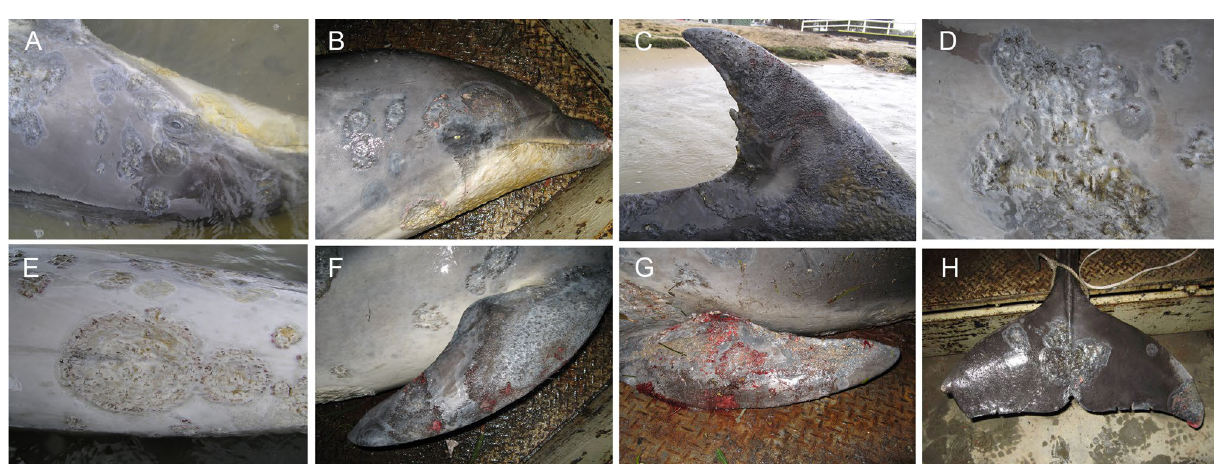
Figure 3. Adult male T. australis (case 2) found dead near Paynesville on Lake King North with extensive epidermal ulceration and discoloration on 1st November, 2007. The lesion morphology and distribution on the head ( A , B ), dorsal fin ( C ), flank ( D ), abdomen ( E ), right pectoral flipper ( F ), left pectoral flipper ( G ) and tail flukes ( H ) are similar to those for the adult female found in the same general area (Fig.